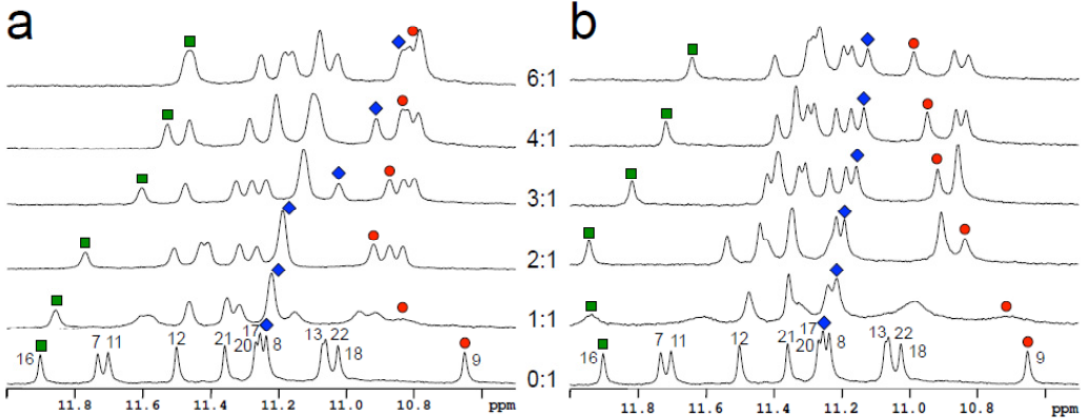
Figure 4. Imino proton spectra of MYC22 quadruplex titrated with the parent cyanine 24 ( a ) and the brominated analogue 31 ( b ). Ligands were added to the quadruplex at the ratio indicated on the plot. Selected imino protons of 3 ʹ -end (9, red) middle (8, blue) and 5 ʹ -end (16, green) tetrads are